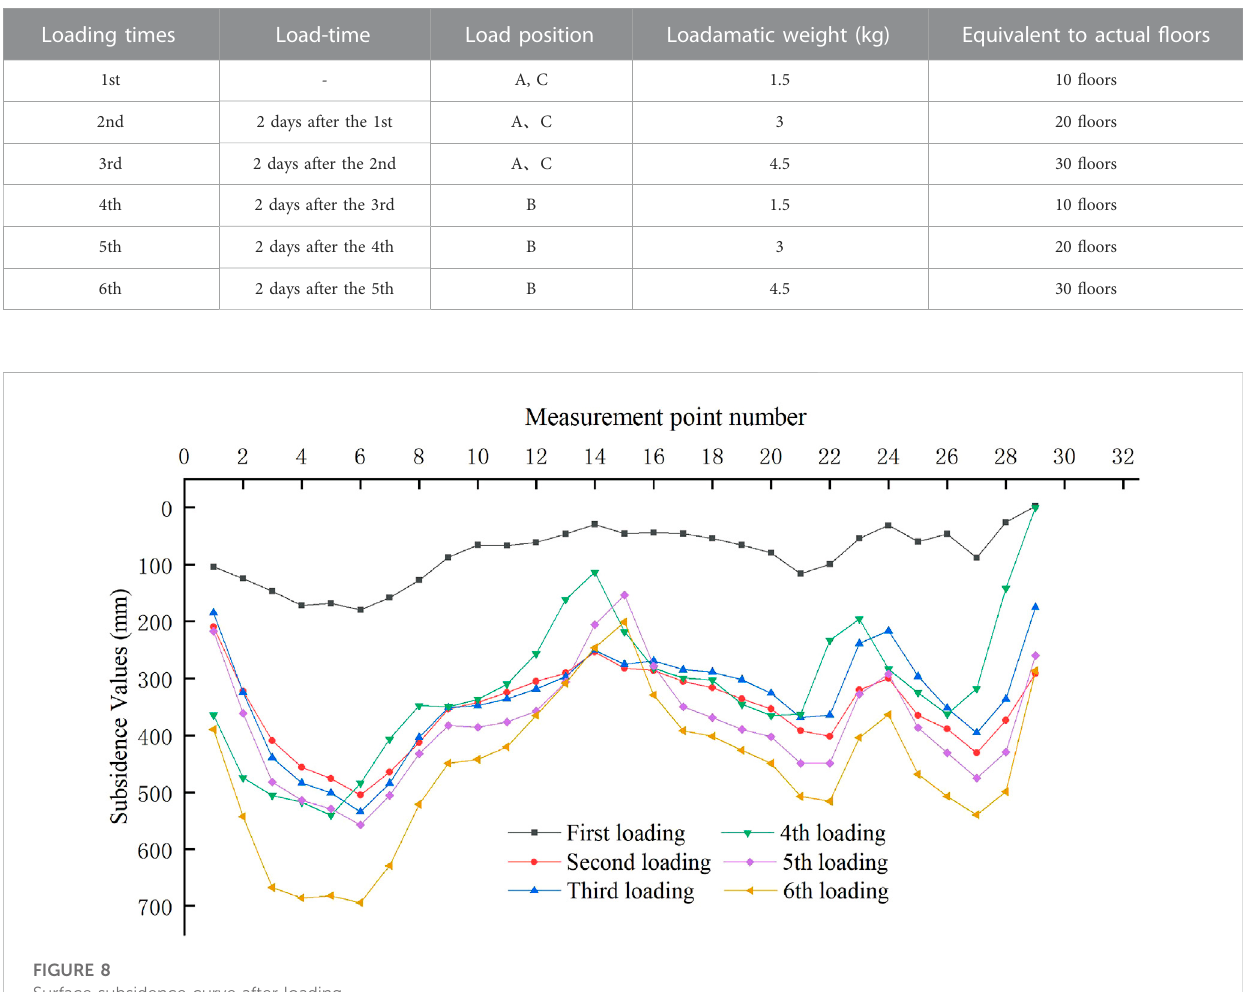
TABLE 2 Loading scheme.